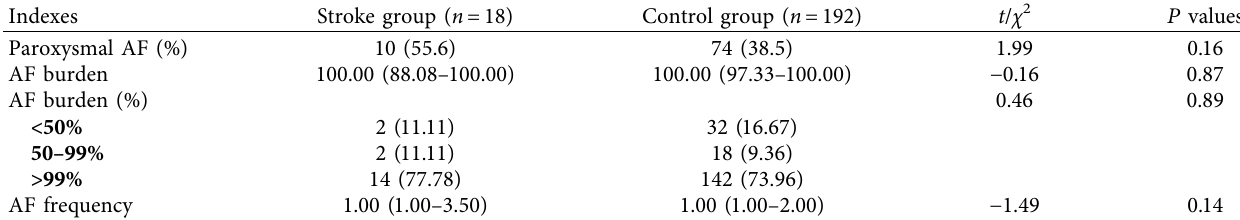
Table 2: Holter ECG monitoring of patients.